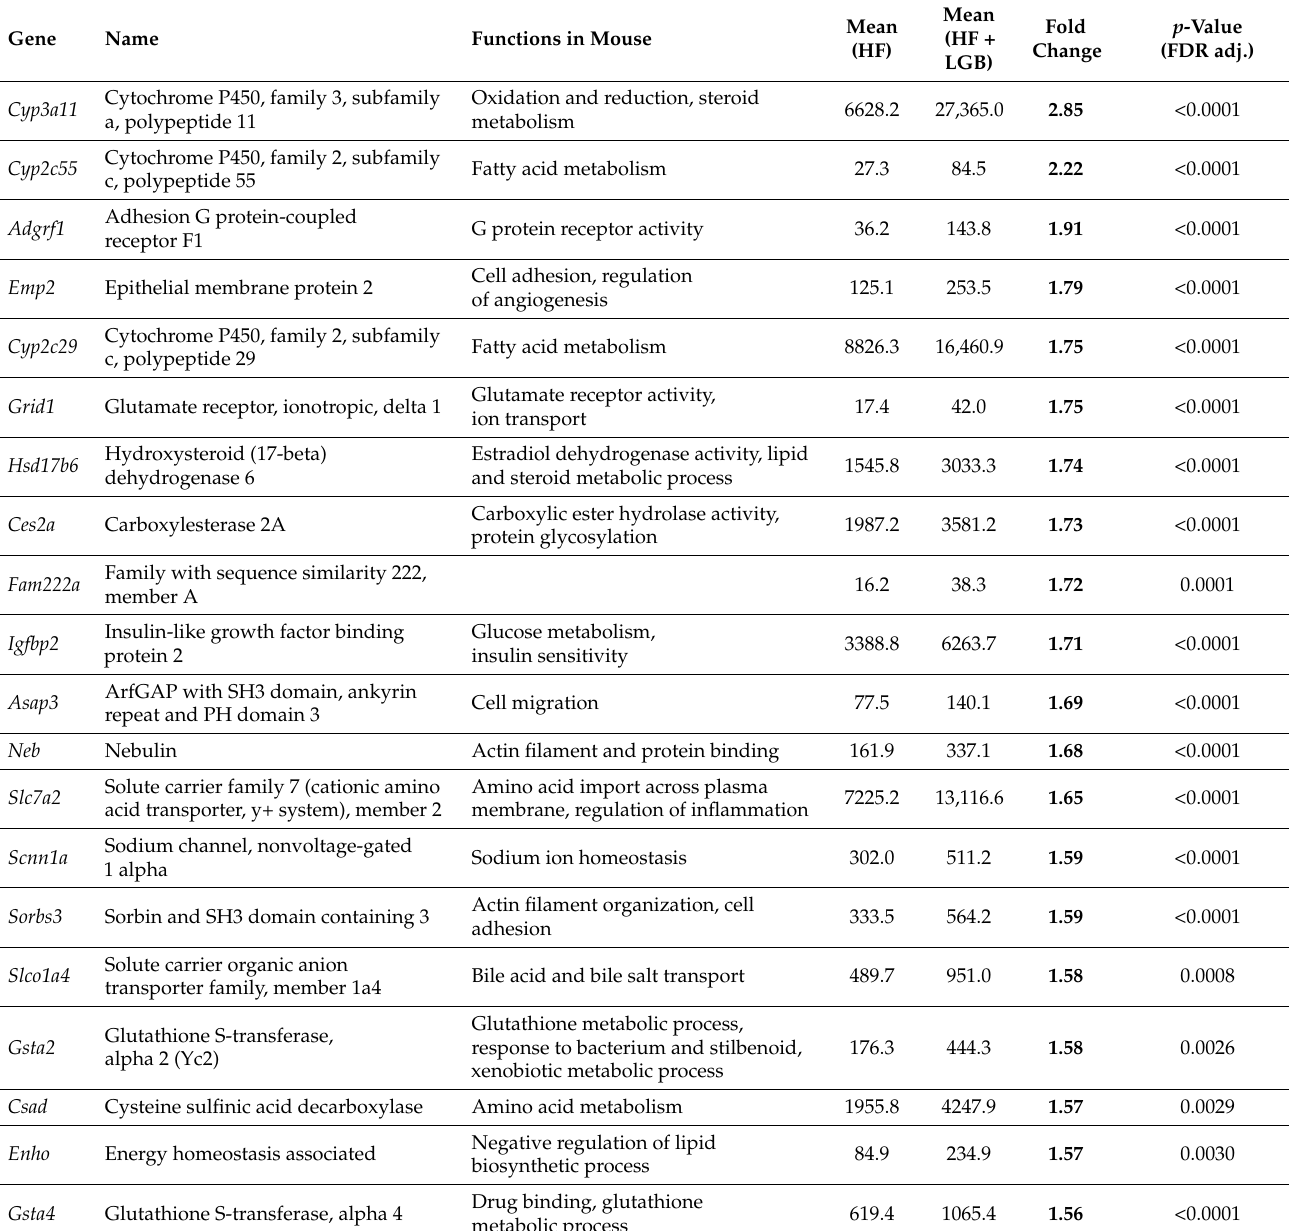
Table 4. The twenty genes with the largest positive fold change (FC) in the lingonberry supplemented high-fat diet (HF + LGB) group relative to the high-fat diet (HF) group. Mean expression levels are given as DESeq2-normalized counts. p -values are adjusted by false discovery rate